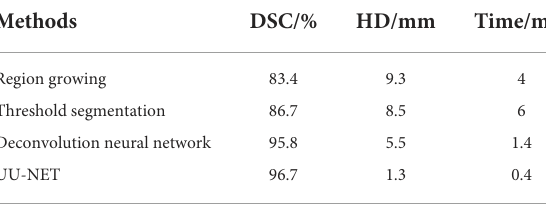
TABLE 1 Result data of each method on validation